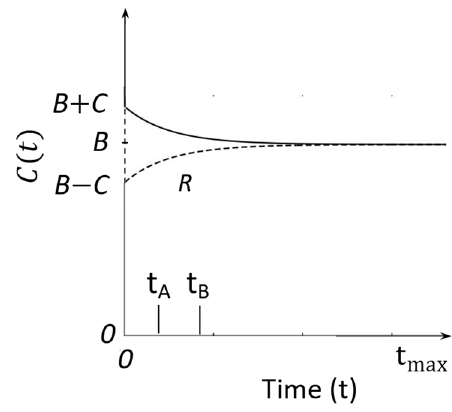
Figure 1. DLTS capacitance transients for minority carriers (solid line) and majority carriers (dashed line), following the removal of a fill pulse at time t = 0. t A and t B represent sampling times for a waveform sampled for a total time, t max .